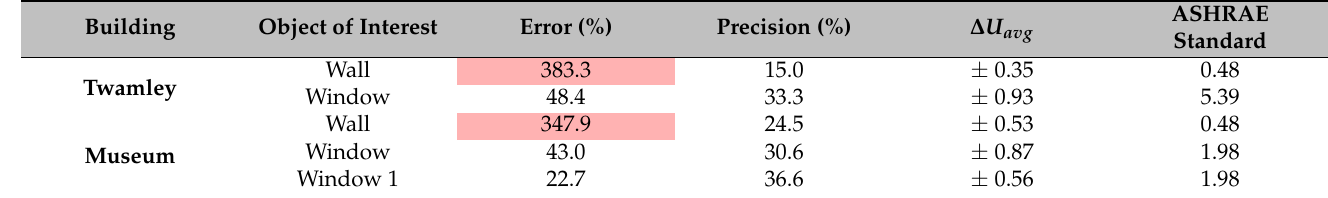
Table 11. The error, precision, and deviation for U-value